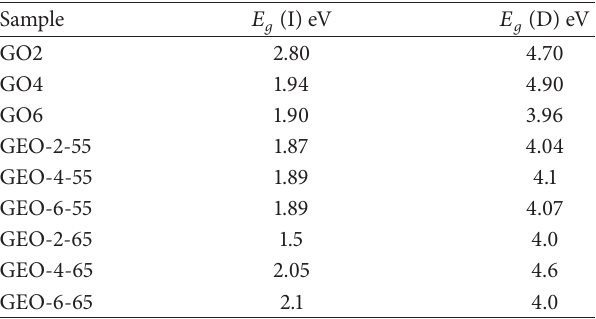
Table 2: Band gap values ( 𝐸 𝑔 ), indirect (I) and direct (D), obtained through spectra of UV-vis for all samples of GO and GEO.